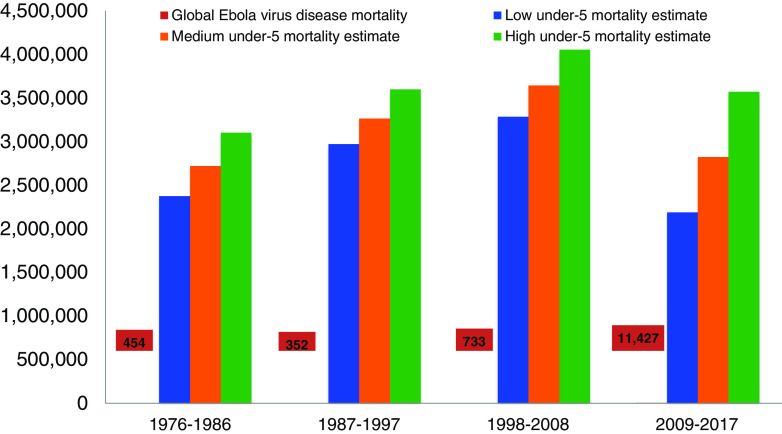
Estimated Cumulative Under-5 Mortality in the Democratic Republic of the Congo Versus Global Ebola Virus Disease Mortality, 1976–2017a,2,8aNote: Ebola virus disease mortality not to scale.